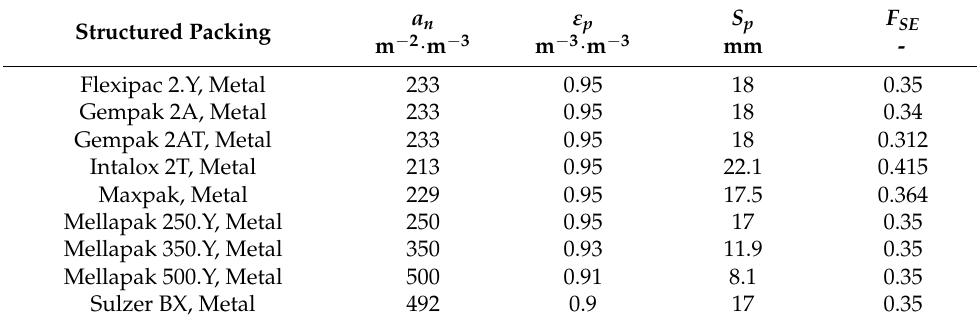
Table 3. Characteristic of several structured packings